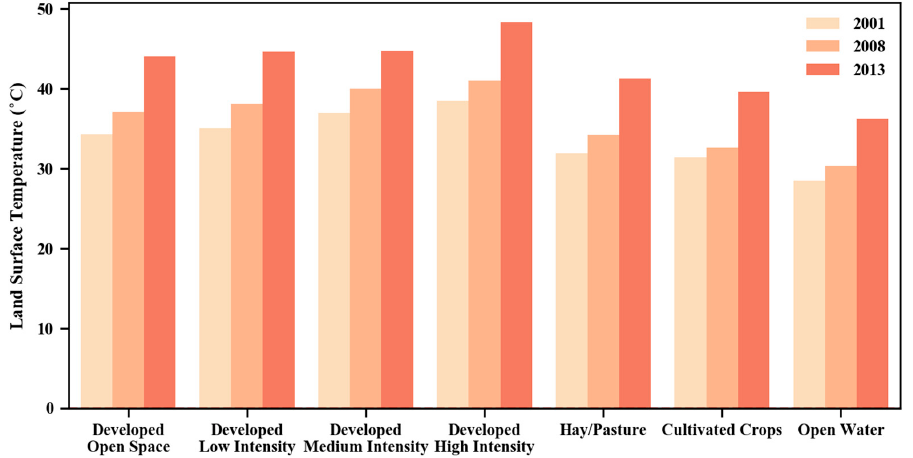
Figure 10. Mean LST by the major LULC type in Boise.